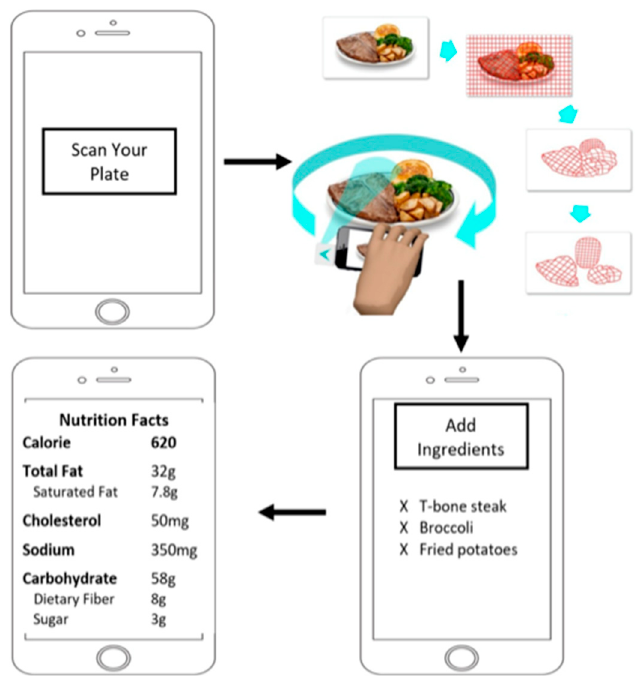
Figure 2. The overall DDRS system and the smartphone application. Starting from the top left, once the user starts the scanning process and the ingredients are added, the nutritional facts are generated based on the amount of food scanned.